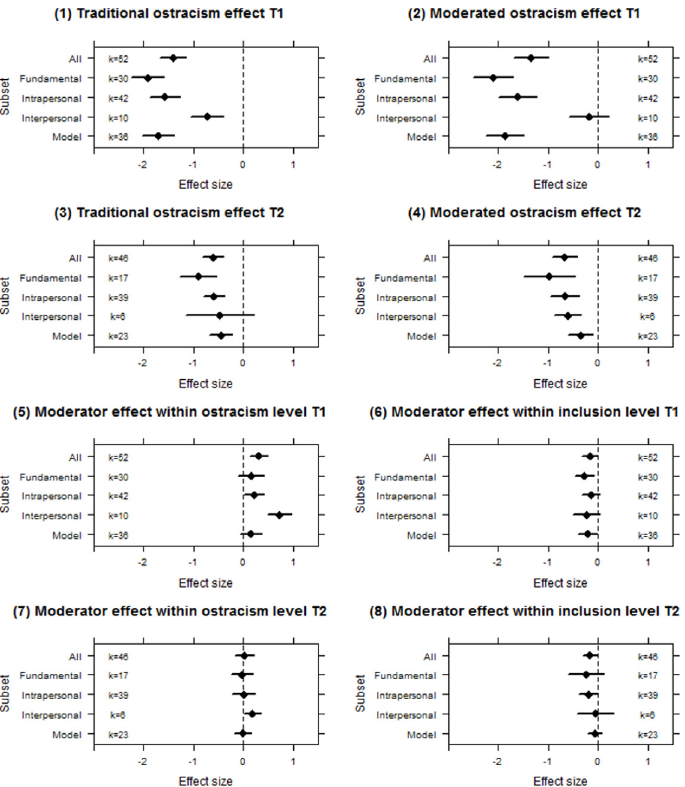
Fig 3. Dotplots of the average estimated simple effects with 95% confidence intervals. T1 represents first measure and T2 represents last measure. These effects are across the same subset. Traditional ostracism effect refers to the between-subjects effect of being ostracized with no moderator present, whereas moderated ostracism effect refers to being ostracized with a moderator present. Vice versa, moderator effect within ostracism/inclusion level refers to the between-subjects effect of the moderator factor, within the ostracized/inclusion conditions. The subset labeled “ All ” contains all measures. The subset labeled “ Fundamental ” contains only fundamental need measures. The subset labeled “ Intrapersonal ” contains all intrapersonal measures. The subset labeled “ Interpersonal ” contains all interpersonal measures. The subset labeled “ Model ” contains those where first measures is immediate and last measure is delayed. See S4